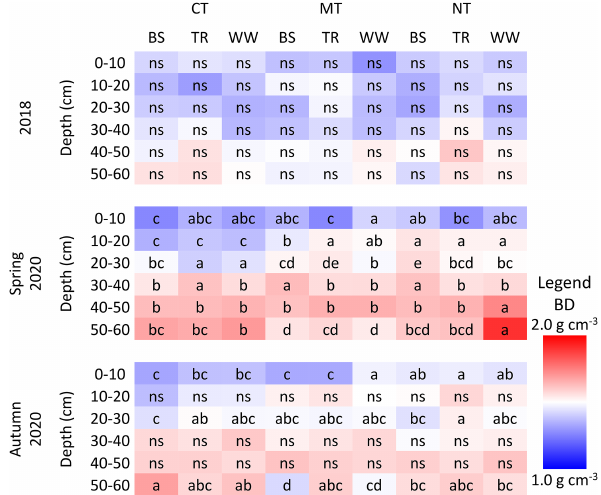
Figure 2. Bulk density (BD) distribution along the 0–60cm soil profile. For each soil layer, the letters indicate the significant effects of tillage × CCs, according to the Tukey test ( p < 0 . 05). Note: CT – conventional tillage; MT – minimum tillage; NT – no-tillage; BS – bare soil; TR – tillage radish; WW – winter wheat.